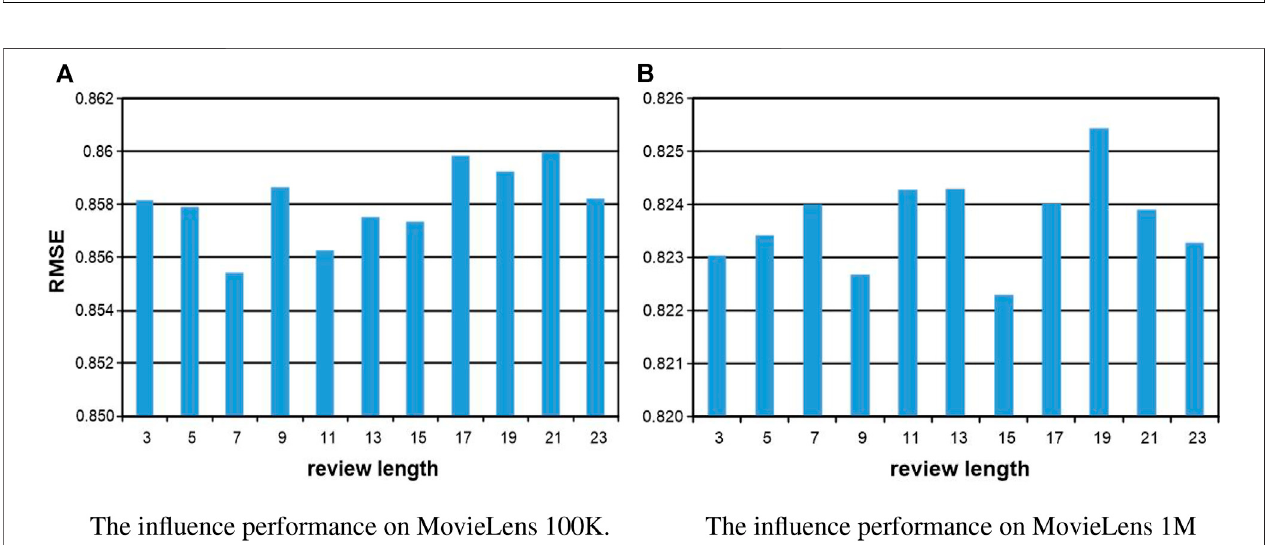
FIGURE 7 | The parameter in fl uence of the length of comments on our KGTA. (A) The in fl uence performance on MovieLens 100K. (B) The in fl uence performance on MovieLens 1M.